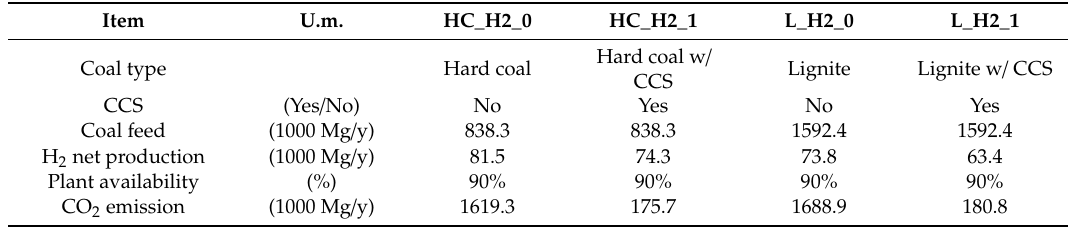
Table 1. Key variables that describe the analyzed variants of hydrogen